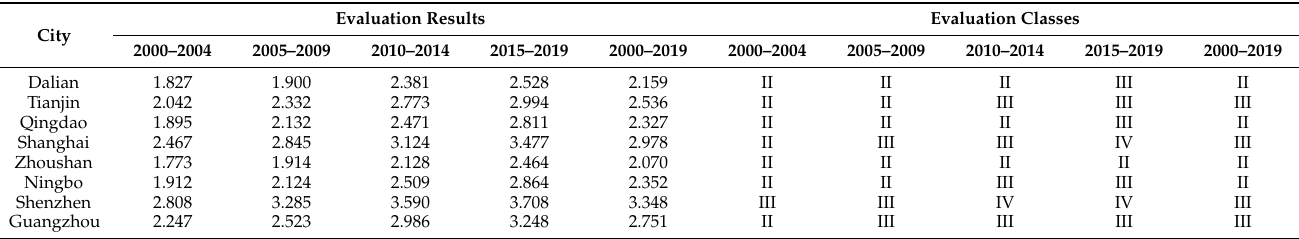
Table 4. Evaluation results and grades of